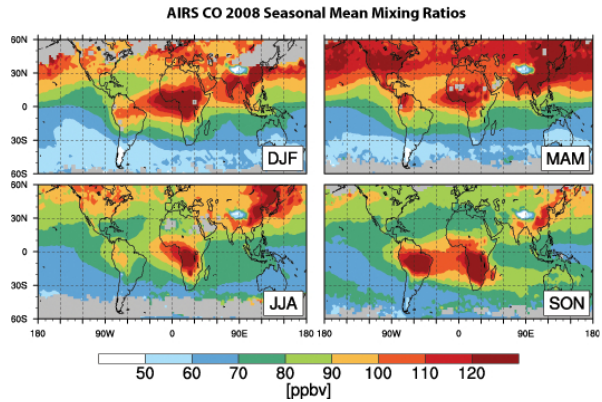
Fig. 1a. Seasonal mean AIRS CO mixing ratios at 700–400hPa for 2008. Data are plotted on the 2 ◦ × 2.5 ◦ GEOS-Chem grid. Gray indicates insufficient data (see text).